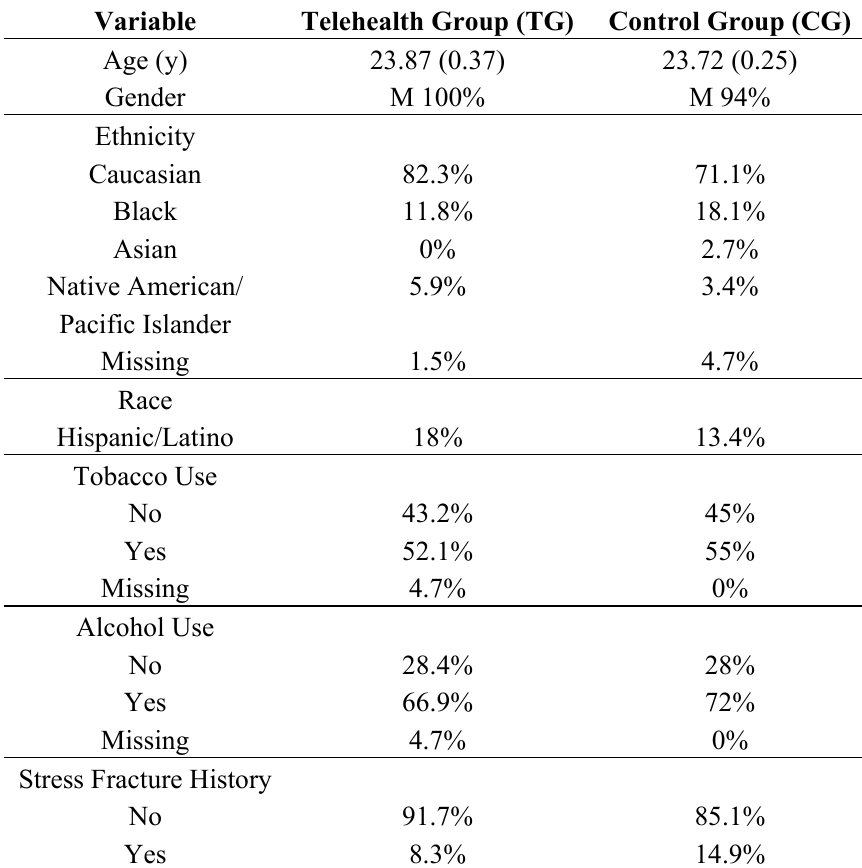
Table 1. Demographic